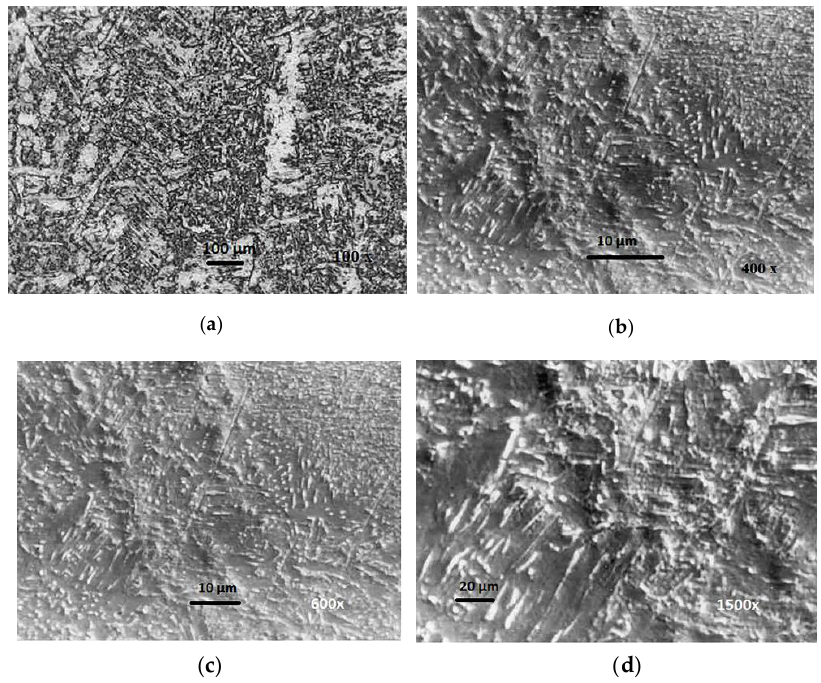
Figure 10. OM ( a ) and SEM ( b , c , d ) microstructure of WM created by electrode No.1.1.